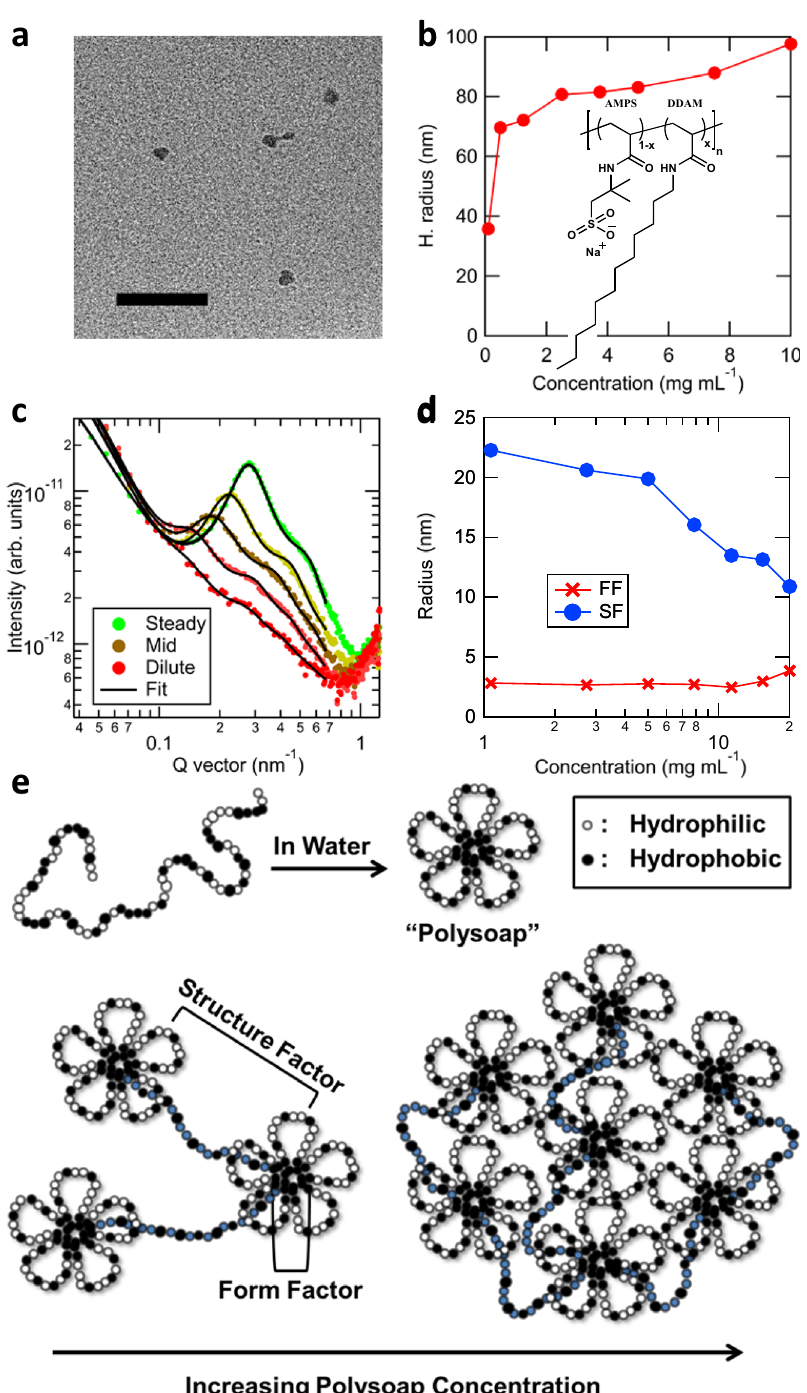
Fig. 4 Multimodal investigation of aPS50 micelles. a Dry TEM images acquired by allowing a 2 wt. % aqueous aPS50 solution to dry within the instrument. Scale bar is 100 nm. b Micelle hydrodynamic radius as a function of concentration of an aPS50 solution in water acquired by light scattering. aPS50 Molecular structure is inset, where x ¼ 0 : 5. c Selected in situ RSoXS pro fi les at a photon energy of 287.3 eV of 2 wt. % aPS50 replacing DI H 2 O within the fl ow cell. Fits of scattering pro fi les represent a spherical form factor with a hard-sphere structure factor, see Supplementary Fig. 13 for individual Structure Factor and Form Factor contributions. d Fit results from ( c ) displaying the structure factor and form factor radii vs concentration, calibrated from dynamic fl ow time using static concentration controls. e Illustration of the self-assembly of aPS50 based on the results. The blue shaded chains highlight bridging tie chains between